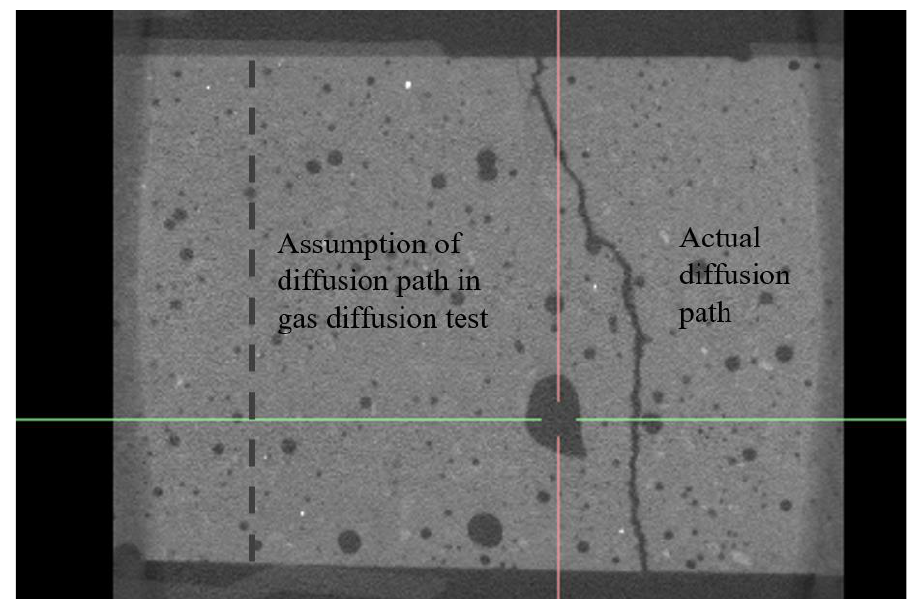
Figure 10. X-ray image of the internal crack shape of the specimen (x – z section).